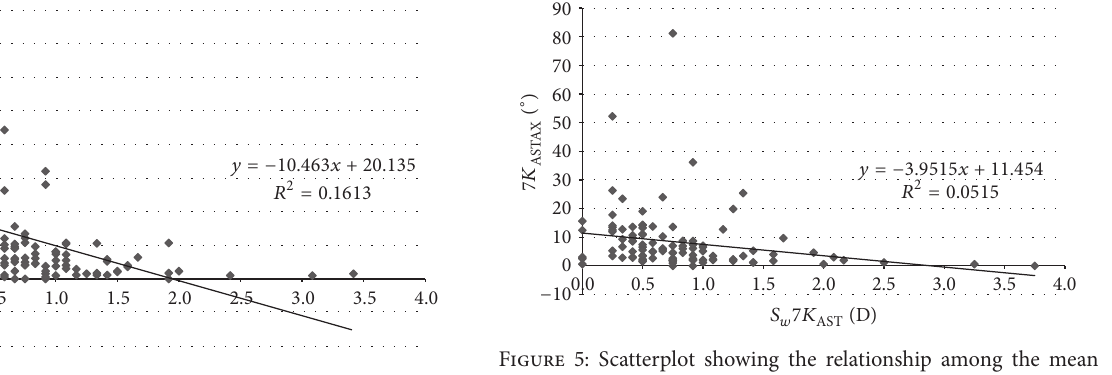
Figure 5: Scatterplot showing the relationship among the mean magnitude of corneal astigmatism in the 7 mm central zone ( 7𝐾 AST ) and the within-subject standard deviation ( 𝑆 𝑤 ) associated with the axis of such corneal astigmatism ( 7𝐾 ASTAX ). The adjusting line of data obtained by means of the least-squares fit is